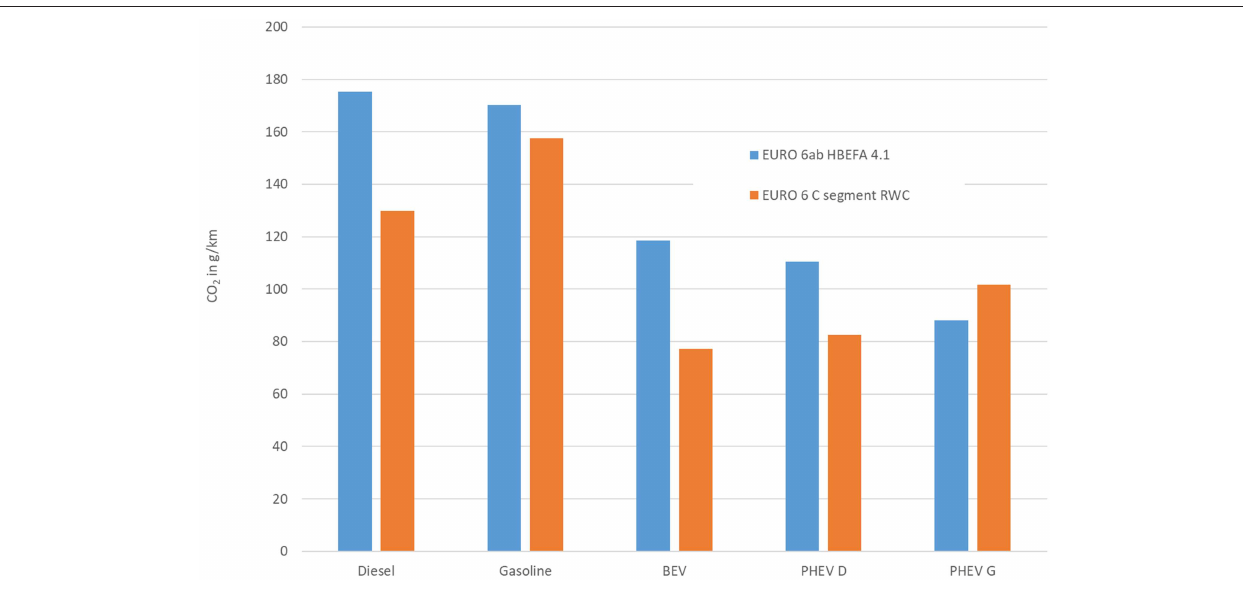
FIGURE 13 | Simulated CO 2 emissions adapted from Matzer et al. (2019) with permission of TU